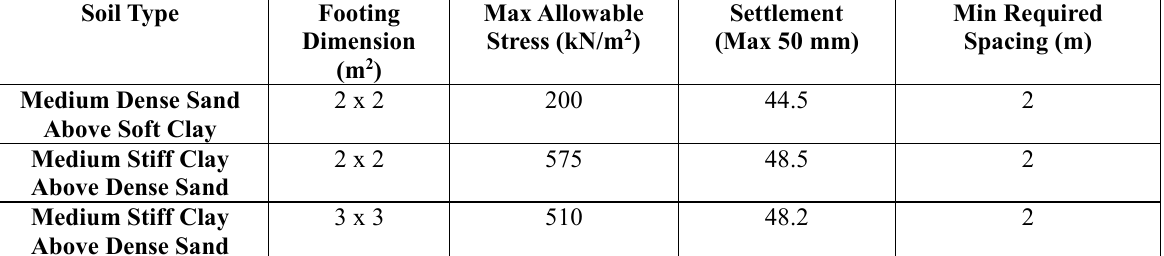
Required minimum spacing for clayey